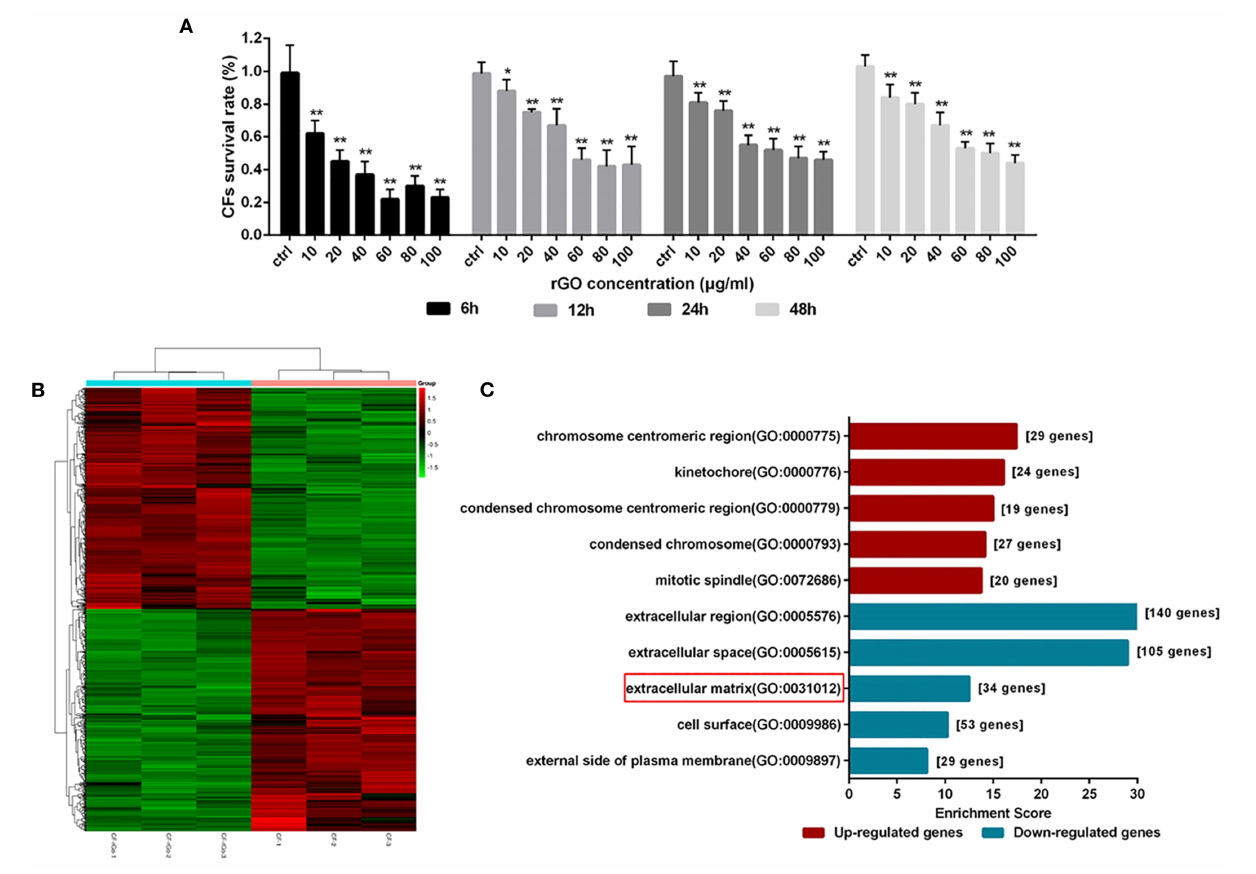
FIGURE 3 | rGO altered cardiofibroblasts (CFs) cell viability and dysregulated gene expression. (A) CFs were treated with rGO at different concentrations; cell viability was determined at different times by using CCK-8 assay. (B) Heatmap of dysregulated genes. (C) GO analysis of differentially expressed mRNAs at the cellular component level. Data are mean ± SEM from three independent experiments. * P < 0.05, ** P <